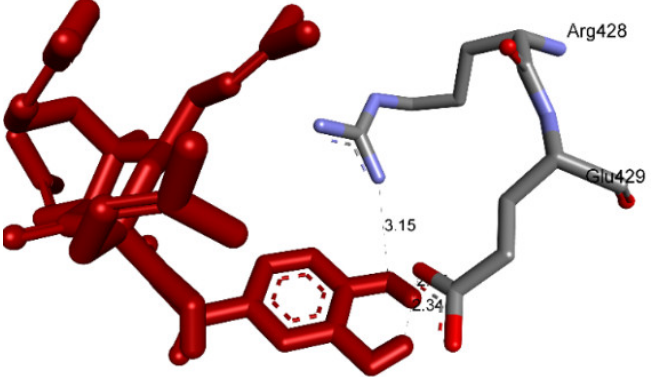
Figure 7. The hydrogen bonding linked from pose 41/200, compound 2 , to active atoms on enzyme 4J5T.